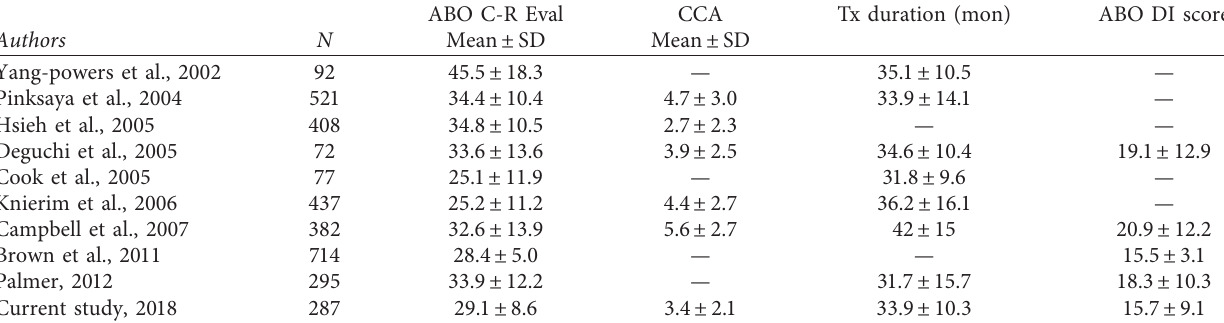
Table 7: Mean treatment quality and efficiency across advanced education orthodontic programs (by publication